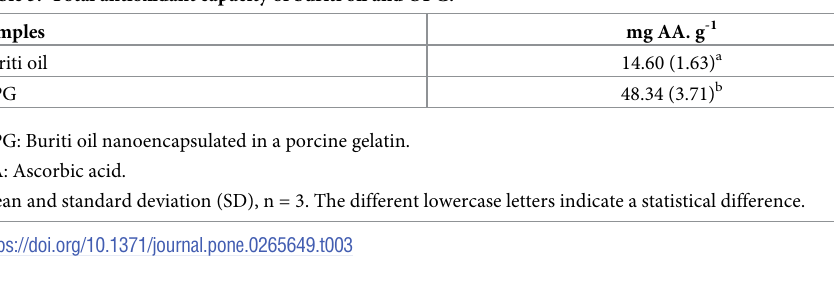
Table 3. Total antioxidant capacity of buriti oil and